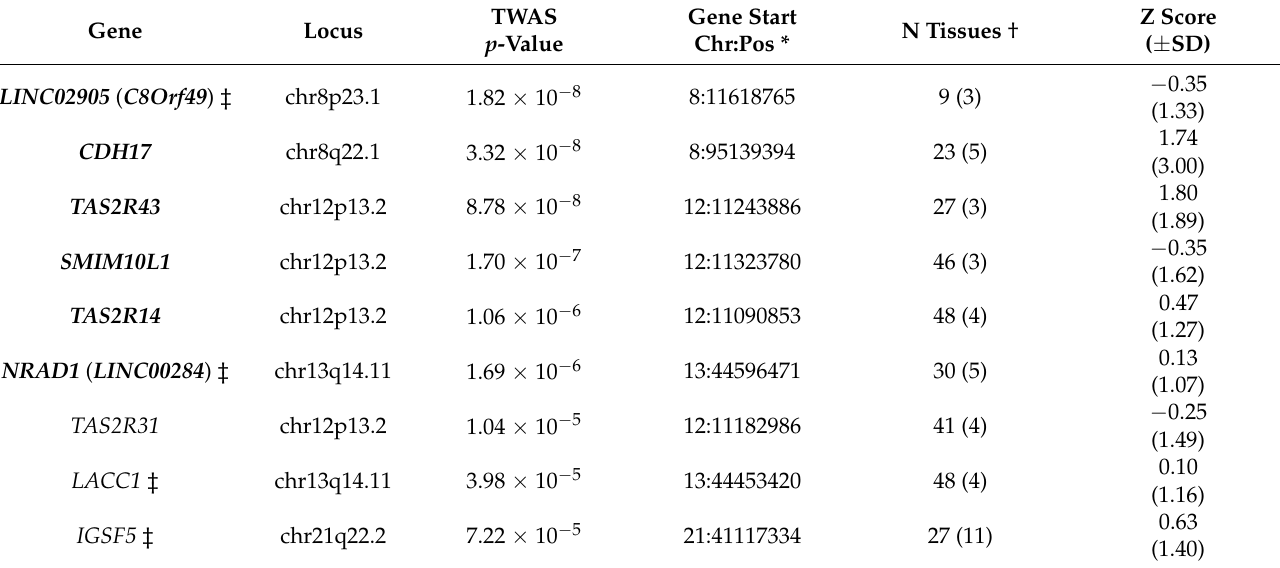
Table 3. Genes corresponding to transcripts associated with early childhood caries (ECC) as identified by transcriptome-wide association study (TWAS). Genes encoding transcripts associated at significant ( p -value < 3.09 x 10 − 6 ) or suggestive ( p -value < 1.0 × 10 − 4 ) significance levels in S-MultiXcan analysis are shown. Genes are annotated for any relationship with early childhood caries.